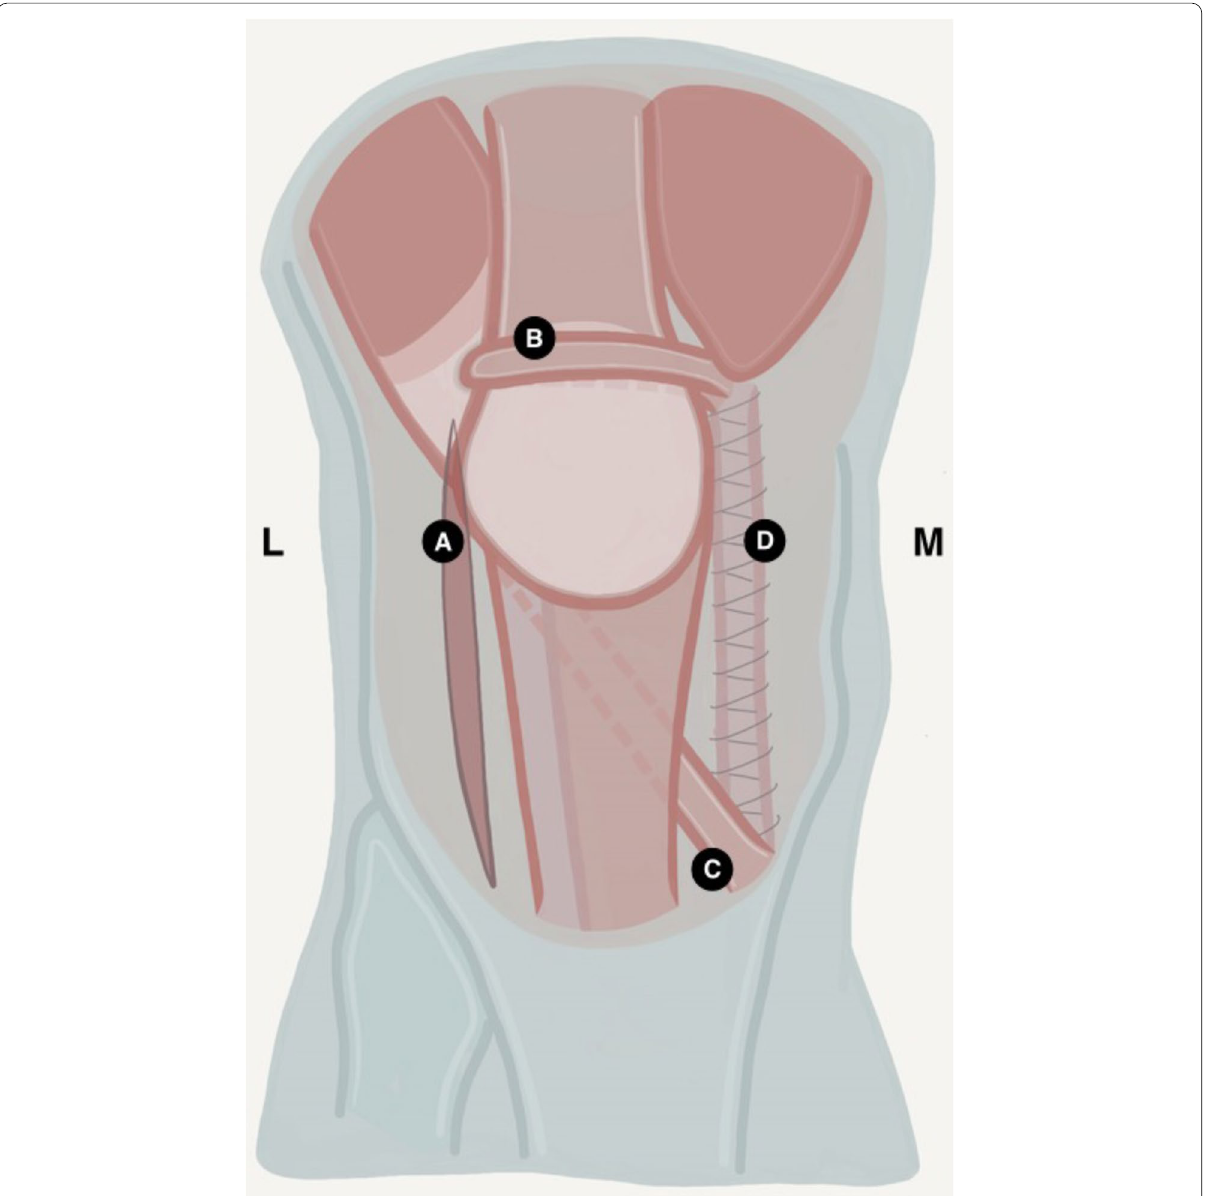
Fig. 1 Schematic illustration of the 4 steps of the SST procedure after 2010. The four steps of the SST-Procedure: a Releasing the lateral retinaculum. b Releasing a strip of the medial retinaculum and transferring the distal part as a loop around the quadriceps tendon after which it is attached to the proximal part. c Releasing the distal lateral quarter of the patella tendon and transferring it below the patella tendon to attach it to the medial side of the tuberositas tibiae. d Reefing the medial